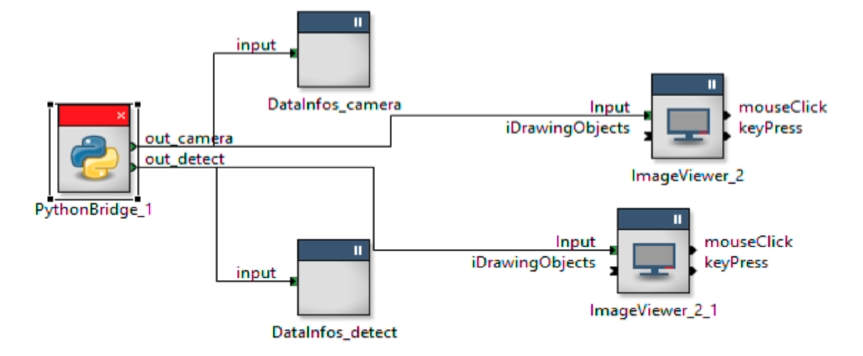
Figure 4. RTMaps diagram. We used the library “Python Bridge” of RTMaps in order to integrate the Yolov5 algorithm on the Jetson